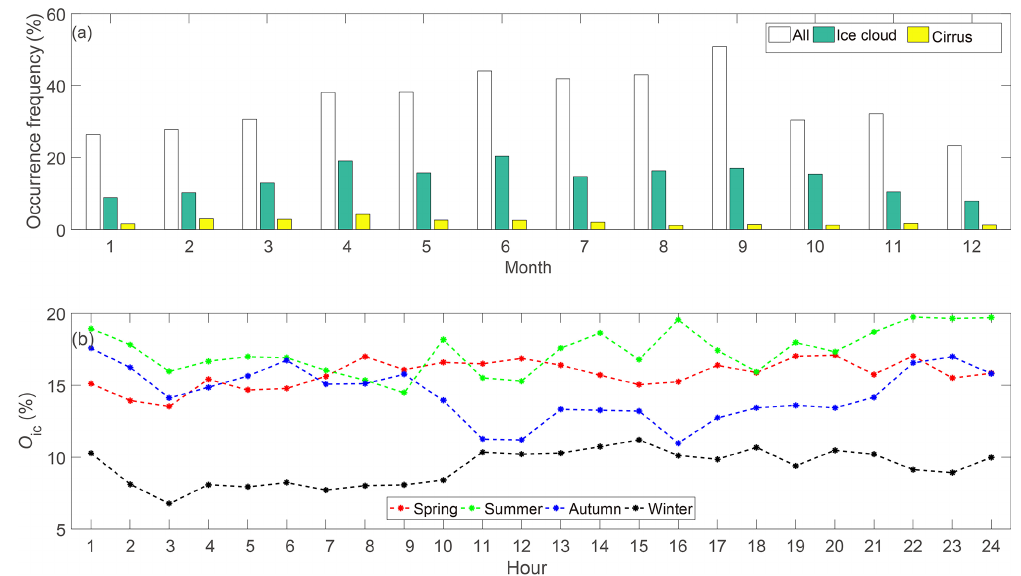
Figure 2. Monthly occurrence frequencies of all clouds ( O all ), ice clouds ( O ic ) and cirrus clouds (a) , along with the diurnal O ic in the four seasons (b) .